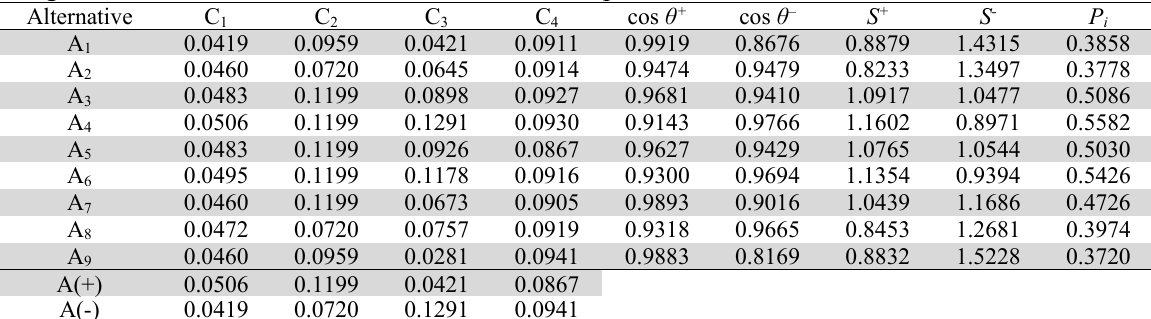
Weighted normalized matrix for soluble oil selection problem Alternative